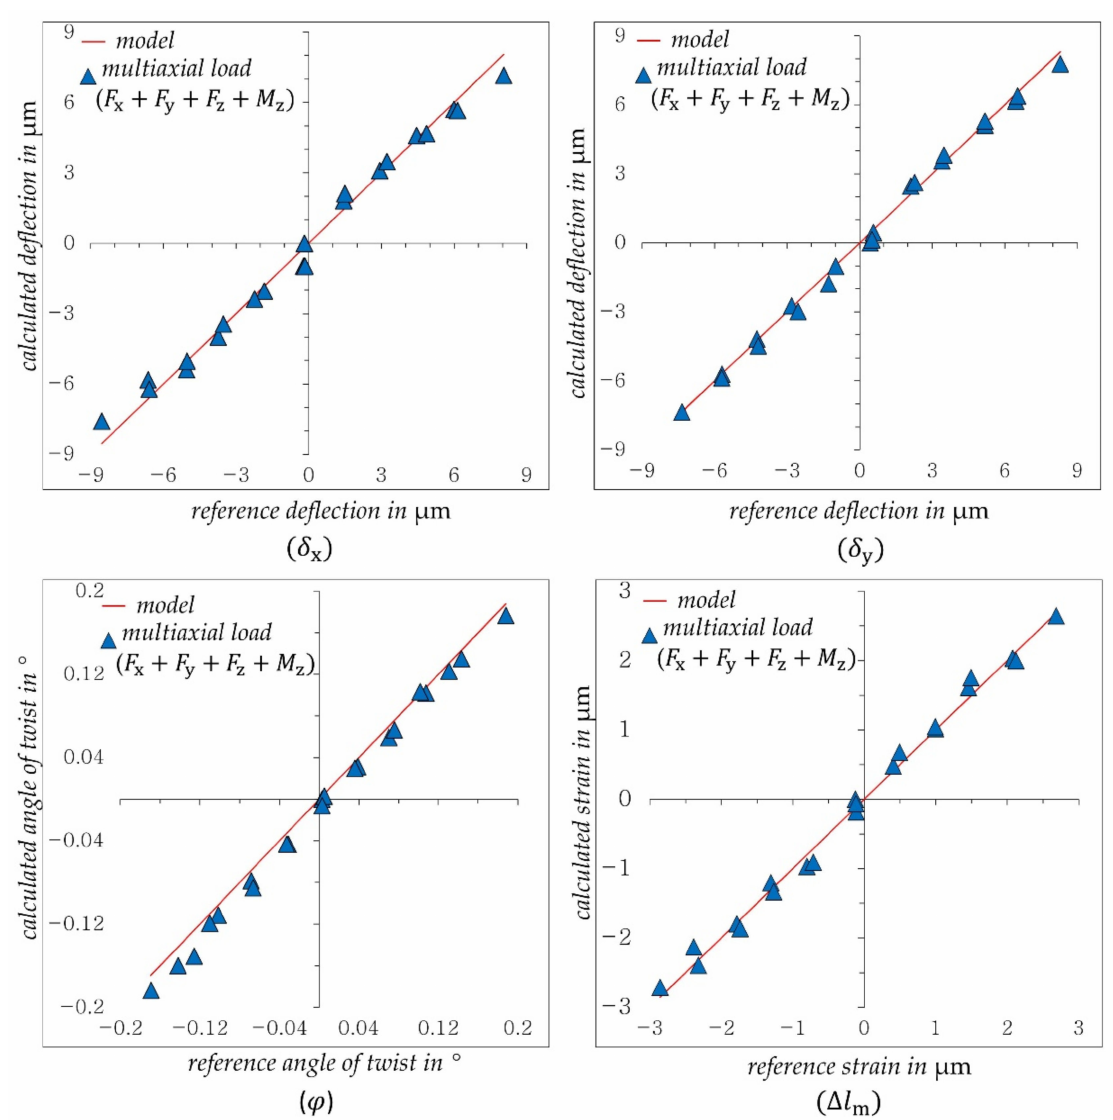
Figure 12. Calculated displacement components ( δ x , δ y , ϕ , ∆ l m ) when multiaxial loading the structure with ( F x + F y + F z + M z